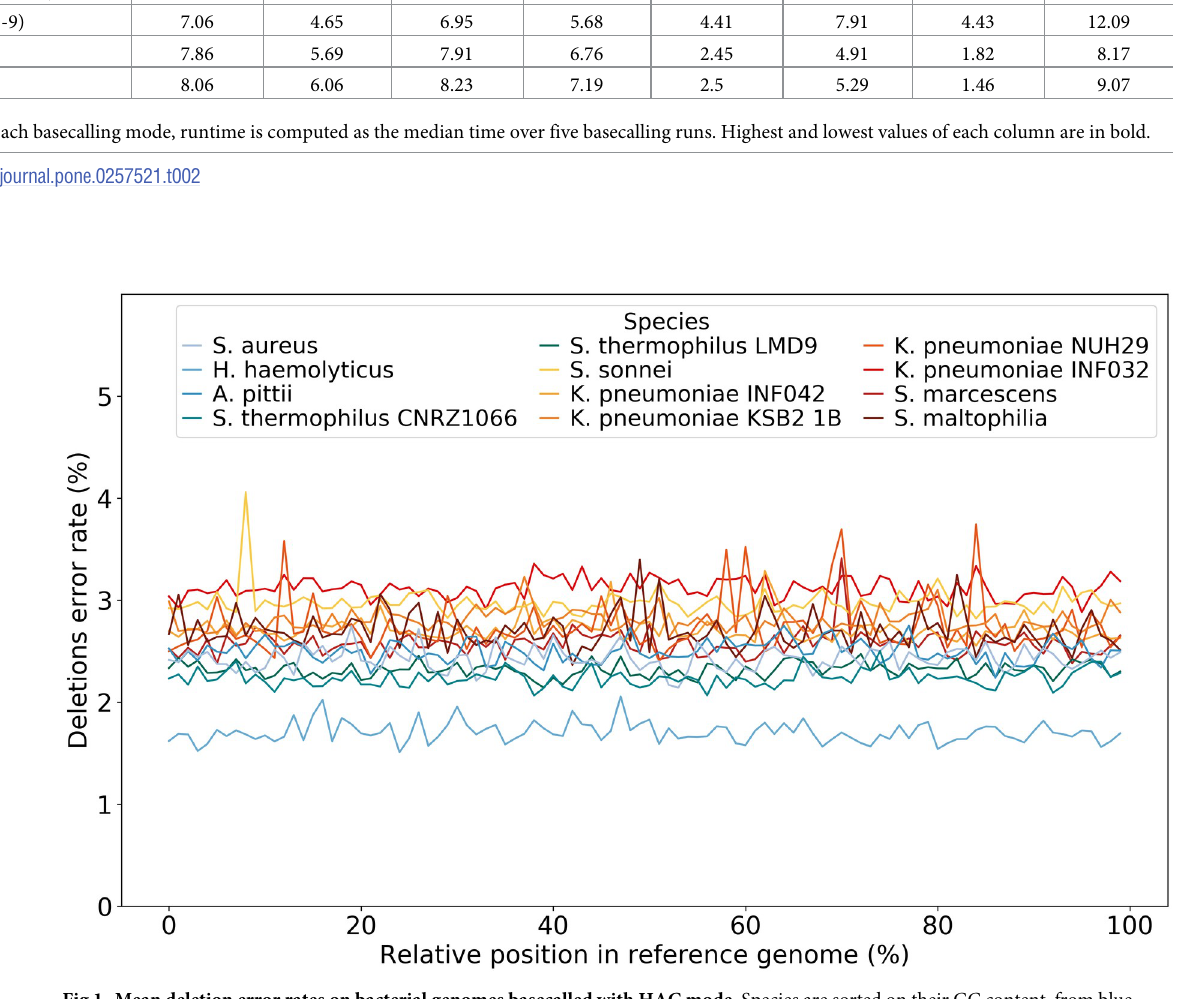
PLOS ONE | https://doi.org/10.1371/journal.pone.0257521 October 1,